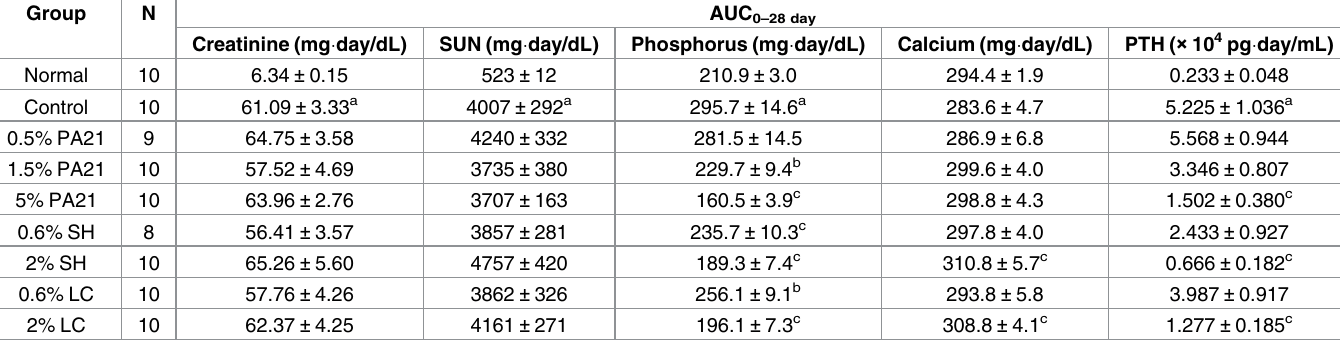
Table 3. AUC 0–28 day of serum biochemical parameters during treatment